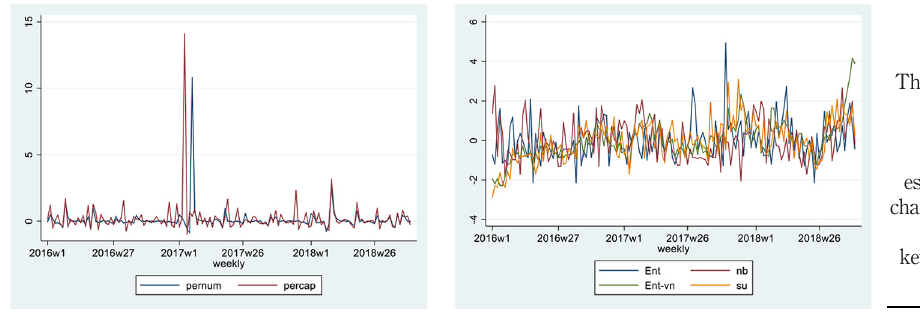
Figure 1. The investigation